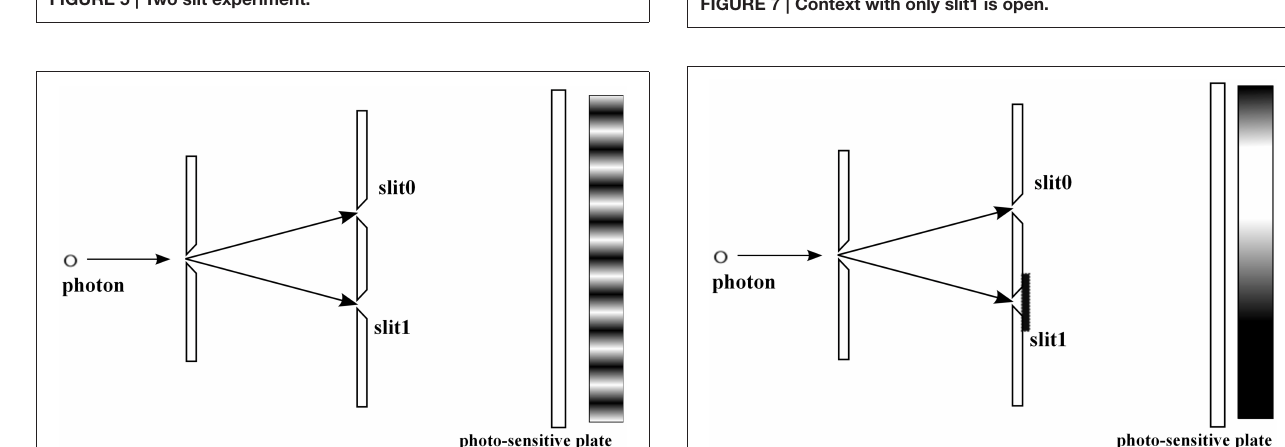
FIGURE 7 | Context with only slit1 is open.